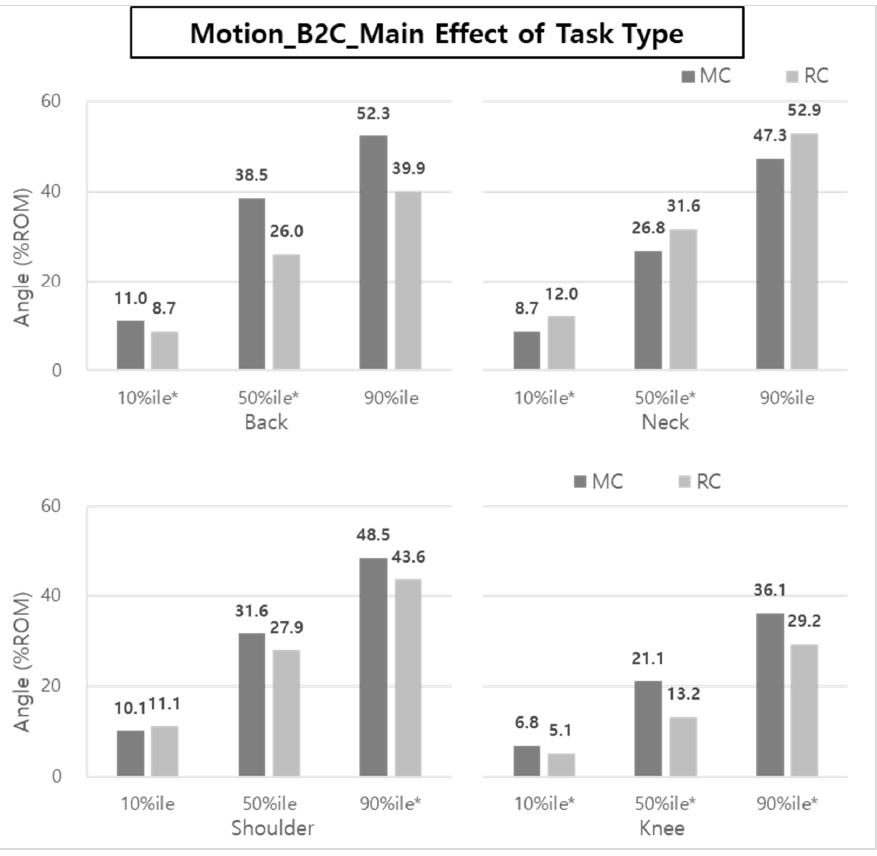
Figure 12. The effect of task type on body posture during B2C. Asterisk (*) indicates that the